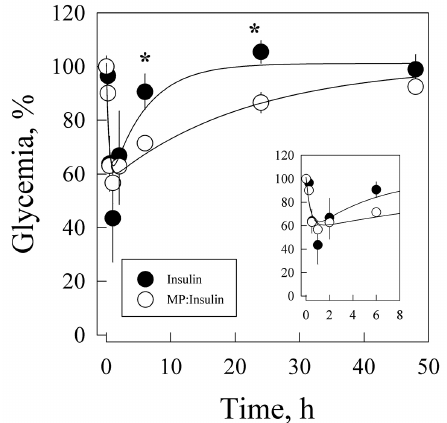
FIGURE 4 - Pharmacological evaluation of MP-insulin in diabetic mices. Streptozotocin-induced mices were administrated s.c. with regular human insulin solution (closed symbols; n=5) or insulin-loaded PCL microparticles (open symbols, n=5) and the glucose level was evaluated. Symbols represent mean ± SD. Inset : glycemia change at initial time range. * p<0.05 (t-test). Lines are non-linear regression with Eq. 1. Details in the Material and Methods